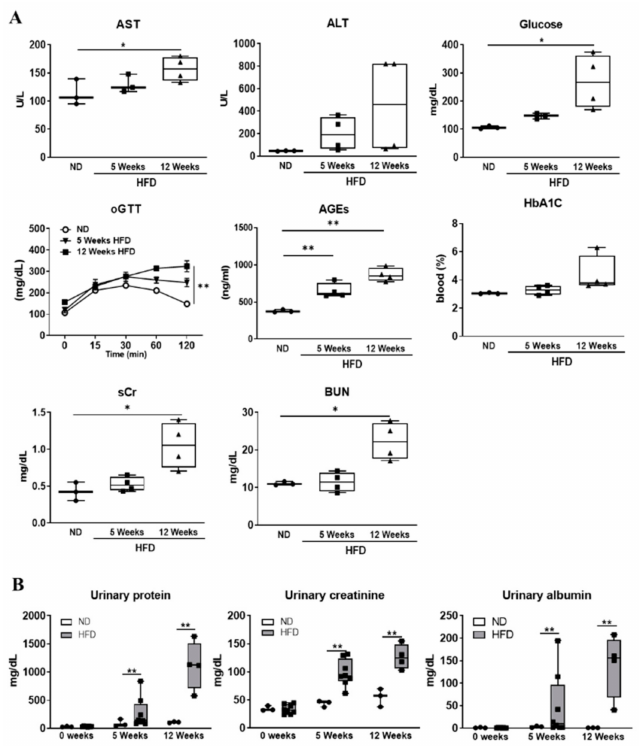
Figure 2. Effect of hyperglycemia on biochemical parameter changes. ( A ) Levels of blood urea nitrogen (BUN), serum creatinine (sCr), glucose, aspartate aminotransferase (AST), alanine amino- transferase (ALT), hemoglobin A1C (HbA1C), glucose, and advanced glycation end products (AGEs) in the blood serum were measured after fasting at the end of experiment. All the above biochemical parameters were analyzed at 12-h fasting state condition. Oral glucose tolerance test (oGTT) was performed to diagnose diabetes. ( B ) Urinary creatinine, albumin, and protein levels estimated at indicated time point. The values represent means ± SEM. * p < 0.05; ** p < 0.01; ND, normal diet; HFD, high-fat